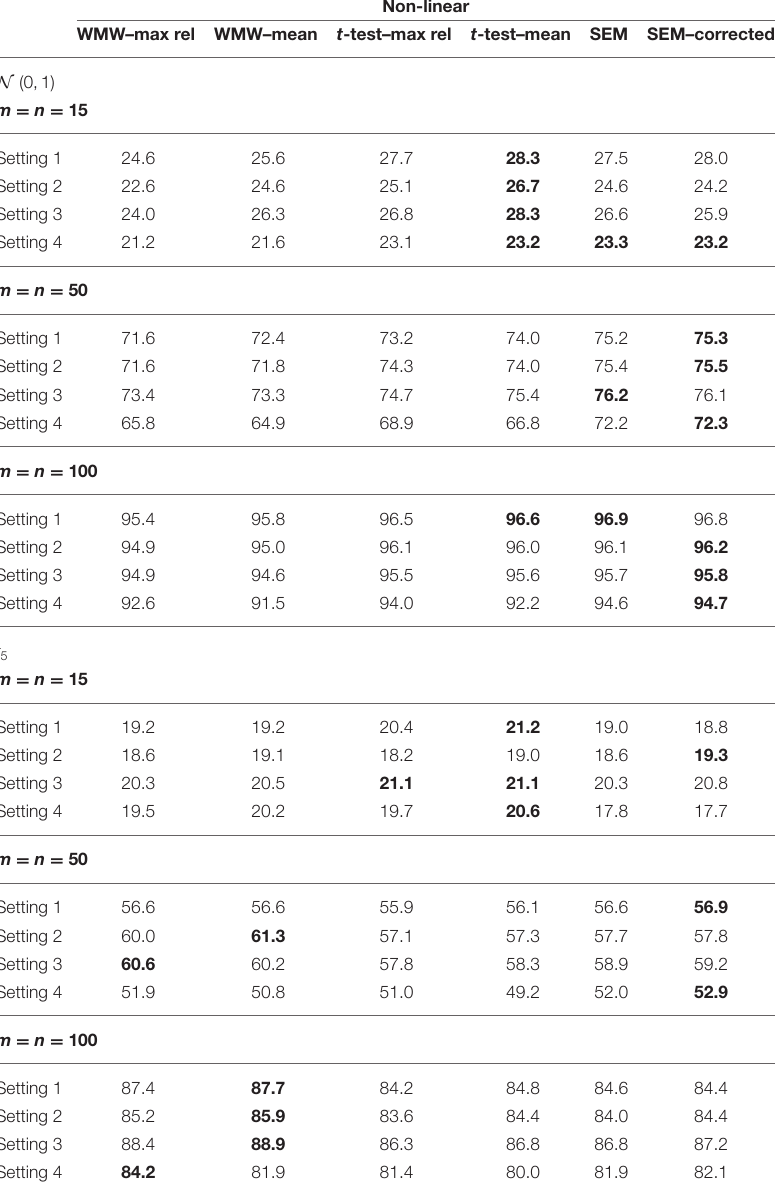
The highest power per setting is indicated in